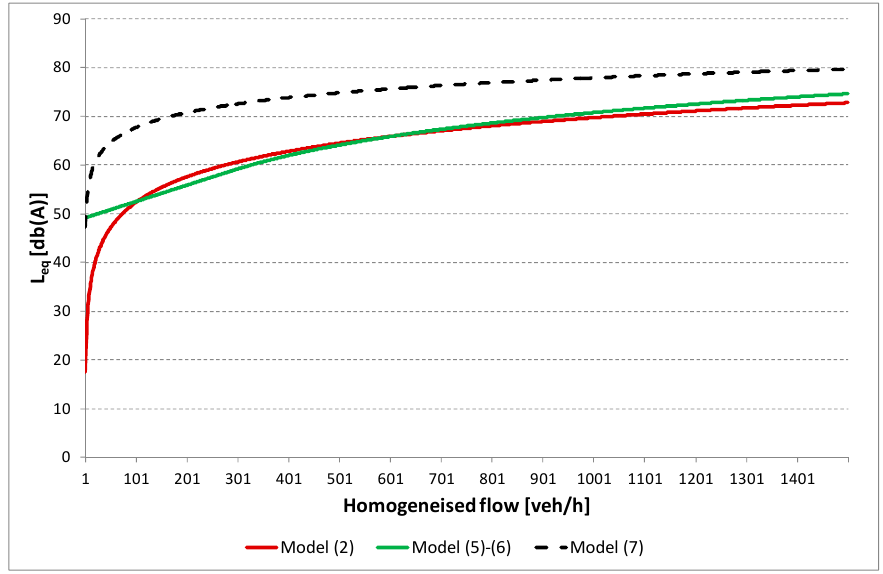
Figure 4. Comparison of models.